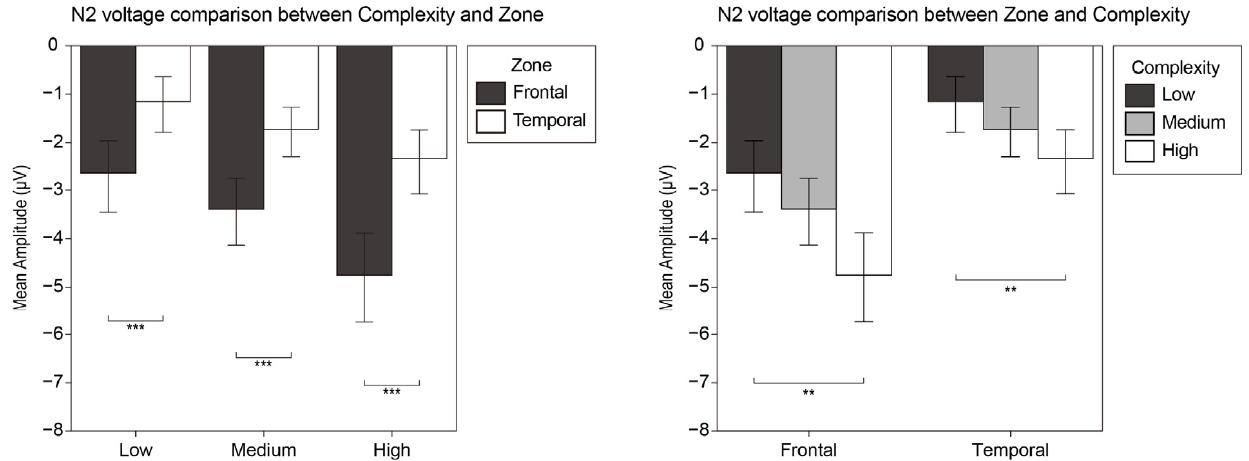
Figure 5. Bar plots of the interaction effect of the N2 component. Values plotted are means ± standard errors. Stars indicate significance levels: ** = p < 0.01 and *** = p < 0.001.